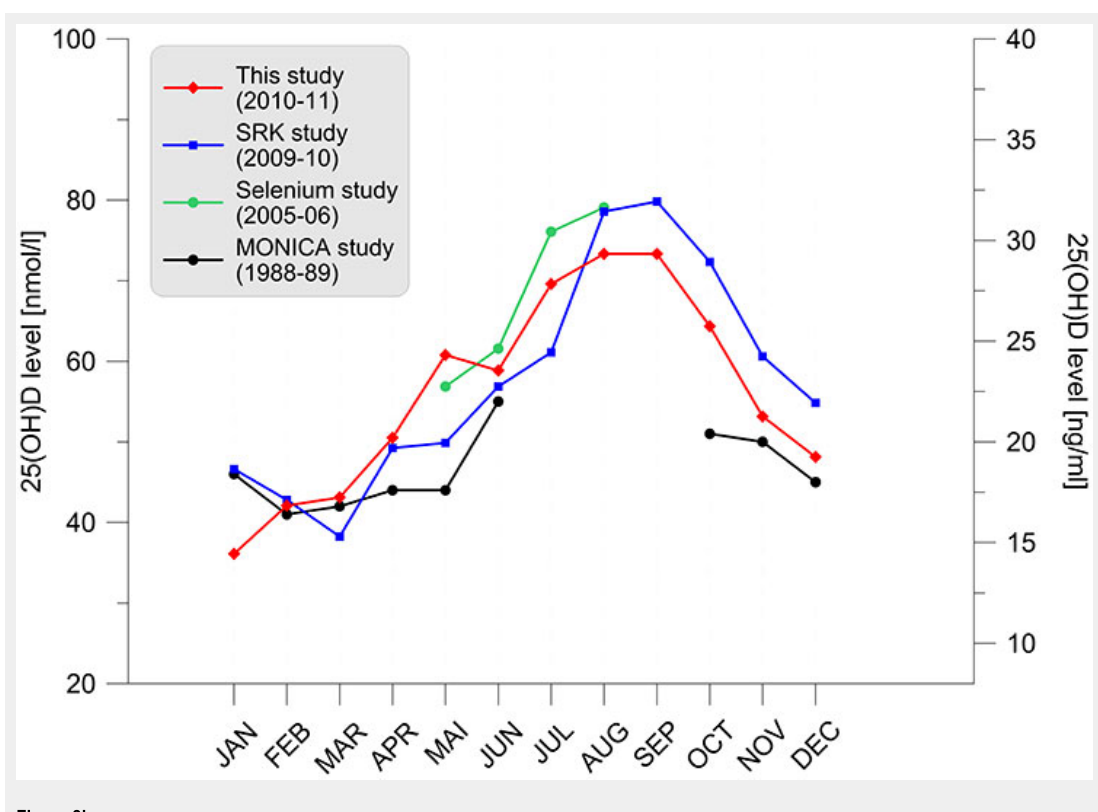
Figure 3b B Variation of the serum 25-hydroxyvitamin D medians per month of examination for different